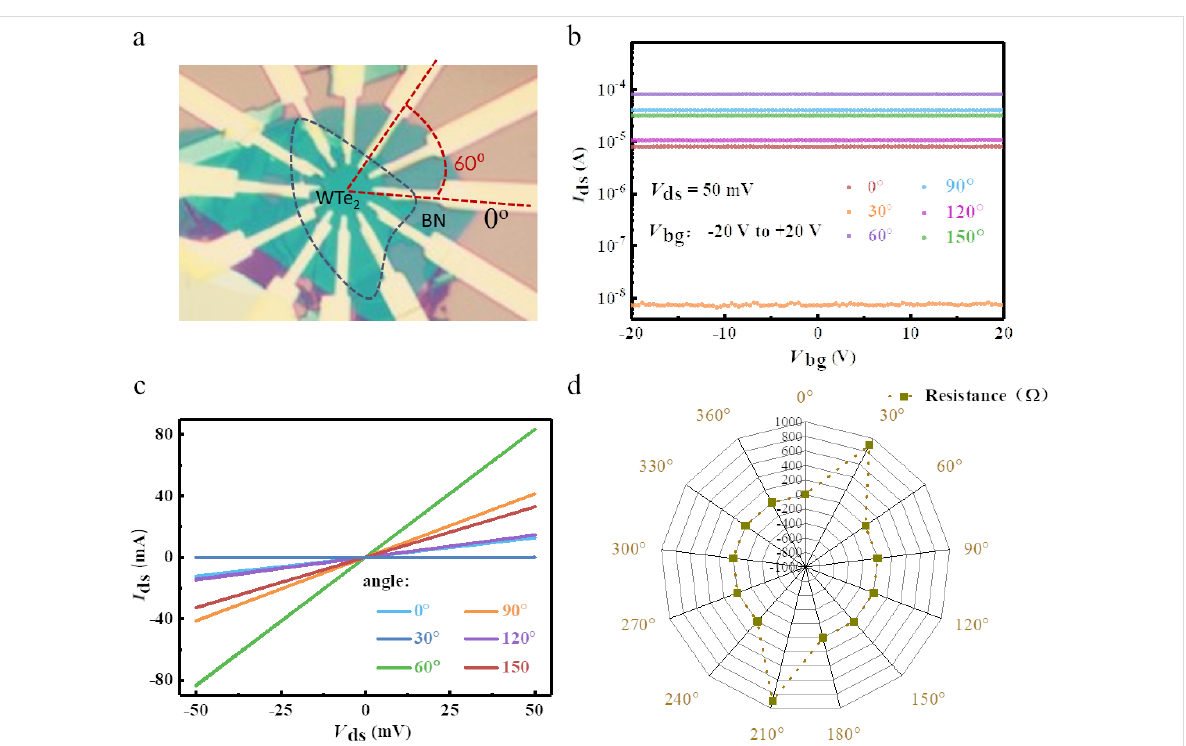
Figure 3: Angle-resolved DC conductivity of a 1T’-WTe 2 thin film. a) Optical image of s WTe 2 flake with 12 electrodes spaced 30° apart. b) and c) are the transfer characteristic curves and the output characteristic curves, respectively. d) Angle-resolved DC resistance presented as a radar